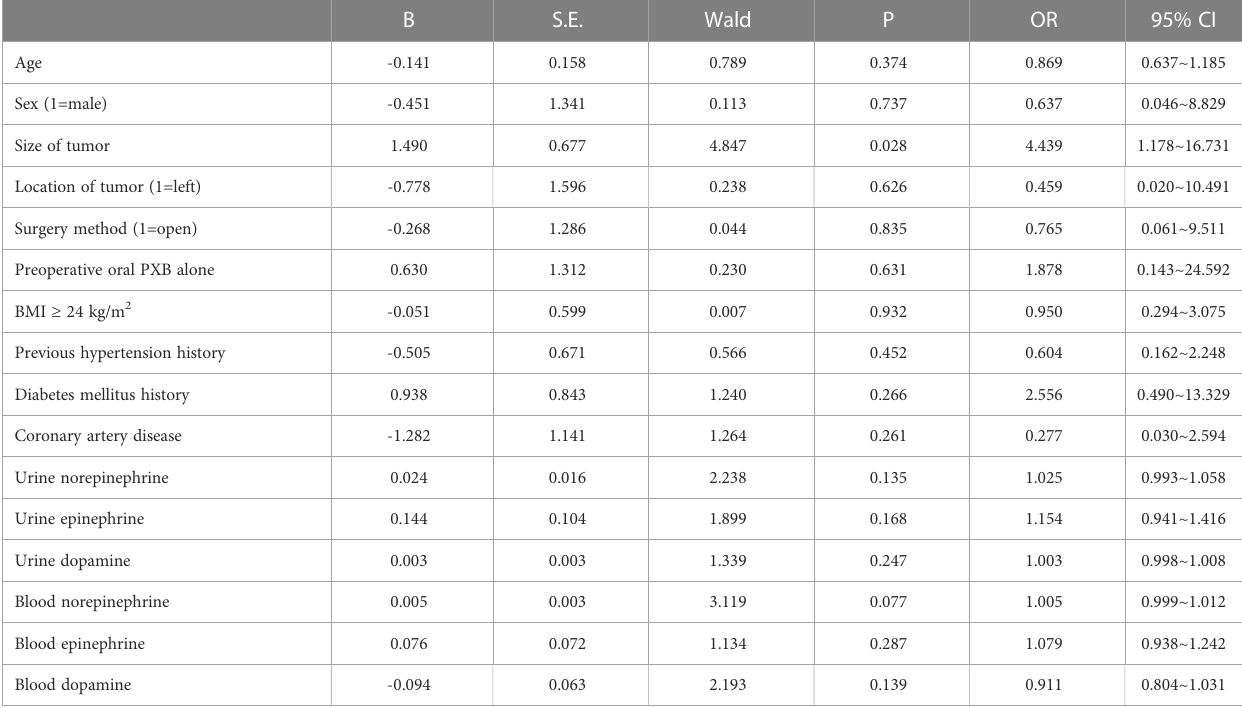
TABLE 3 Multifactorial logistic regression analysis of intraoperative hemodynamic instability in patients with adrenal